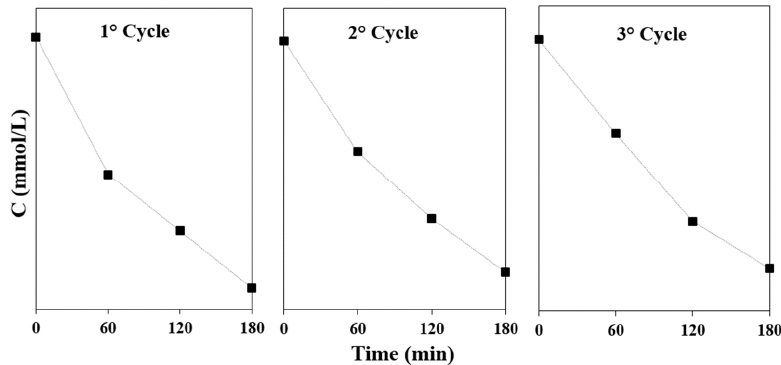
Figure 9. Recyclability test of the as-synthesized nanoparticles for RhB removal under visible-light irradiation.